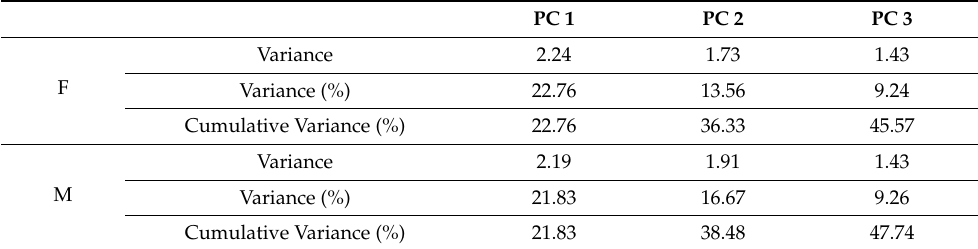
Table 6. Eigenvalues for the first three dimensions of the PCA analysis for female speakers (F, upper panel) and male speakers (M, bottom